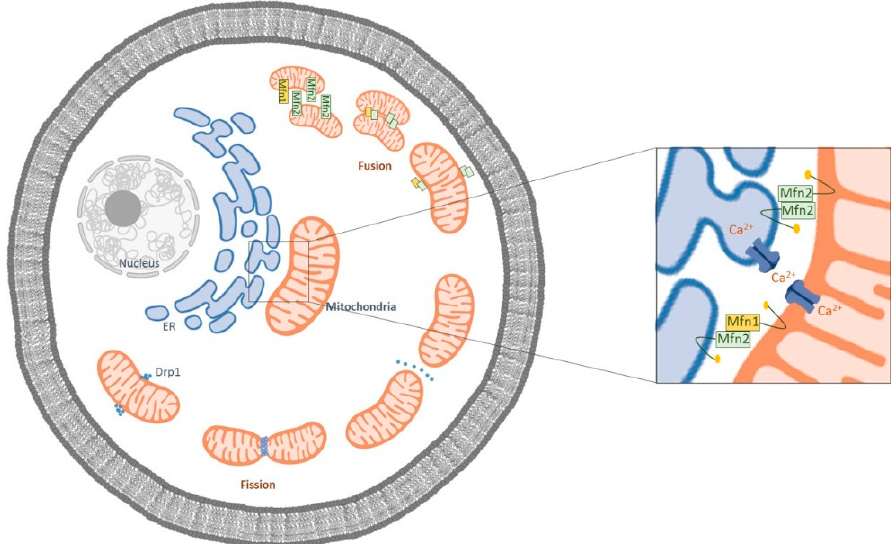
Figure 1. Schematic representation of the mitochondrial fusion and fission processes. Mfn1 is localized in the outer membrane of mitochondria (OMM), and Mfn2 is localized both at the OMM and at the endoplasmic reticulum ER. The ER Mfn2 binds to mitochondrial Mfn1 and Mfn2, regulating ER morphology and leading to the formation of interconnected mitochondria. In the fission process, Drp1 is mobilized to the OMM from the cytosol and is localized to the sites of organelle